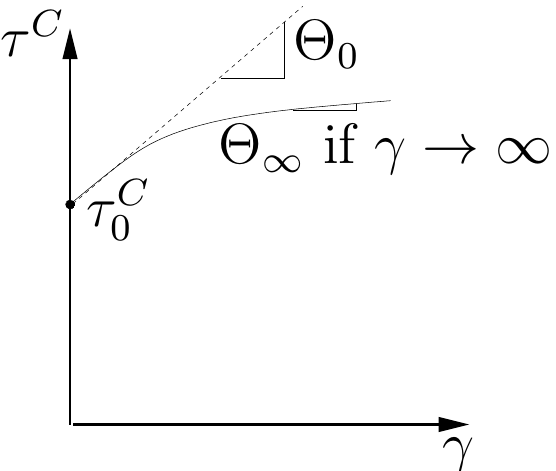
Fig. 5: A sketch to show the work hardening rates Figure 5. A sketch to show the work hardening rates Θ 0 and Θ ∞ . Θ and Θ . 0 ∞